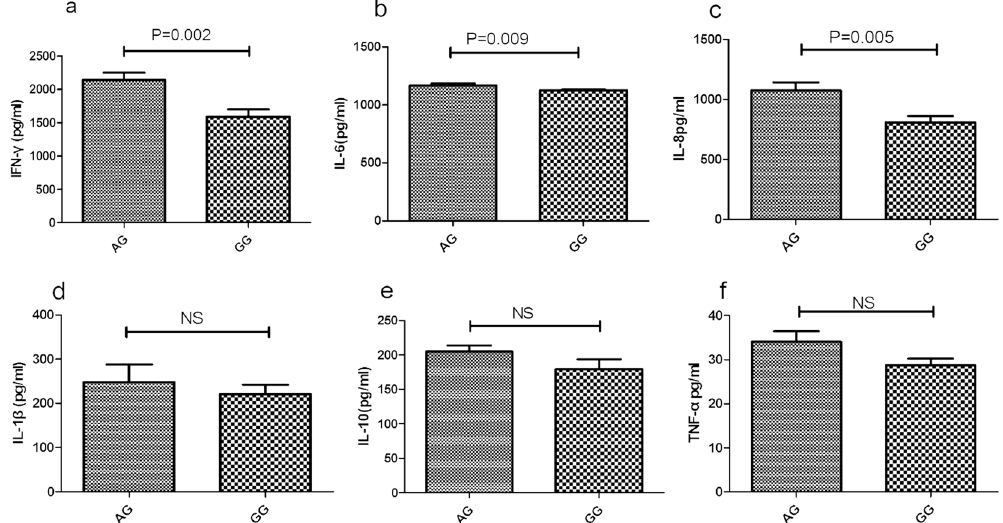
Figure 3. Effect of MBL2 genotype on cytokine production by LPS stimulated PBMCs from healthy genotyped individuals. IFN- γ ( a ), IL-6 ( b ), IL-8( c ), IL-1 β ( d ), IL-10 ( e ) and TNF- α ( f ) were measured by ELISA in the cell culture supernatants. Date expressed as the mean ± SD (AG/GG =